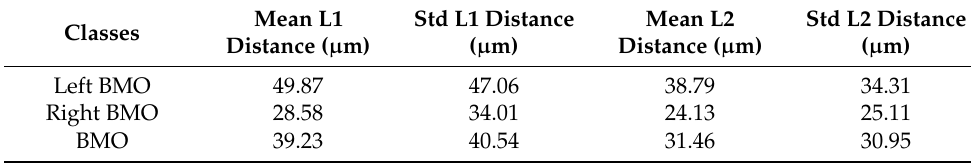
Table 1. Calculations for the values of L1 and L2.